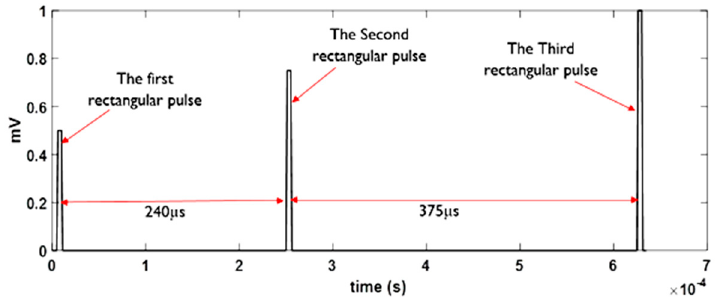
Figure 6. Rectangular pulsing pattern for exciting the source transducer.